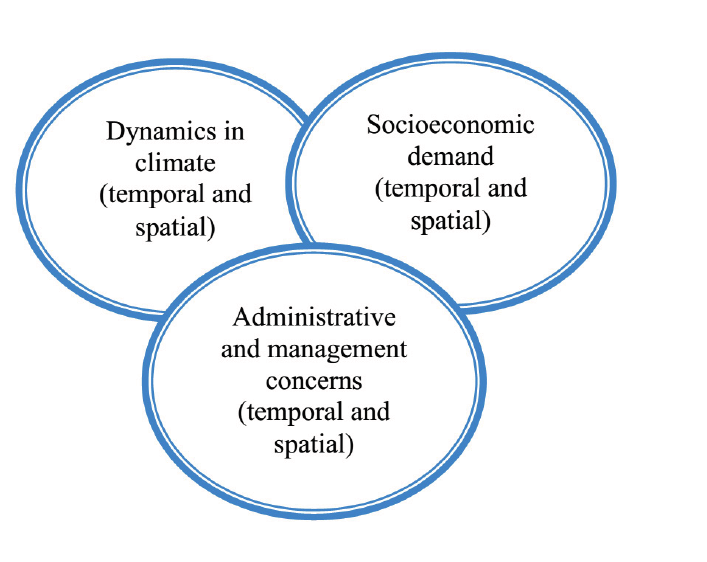
Figure 2. Combination of spatial and temporal scales in Mahaweli Basin water